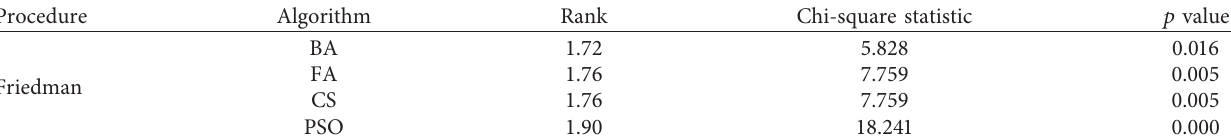
Table 7: Pairwise comparison results over all algorithms with CG-BAT as a control method at α � 0.05 (Experiment 1). Procedure Algorithm